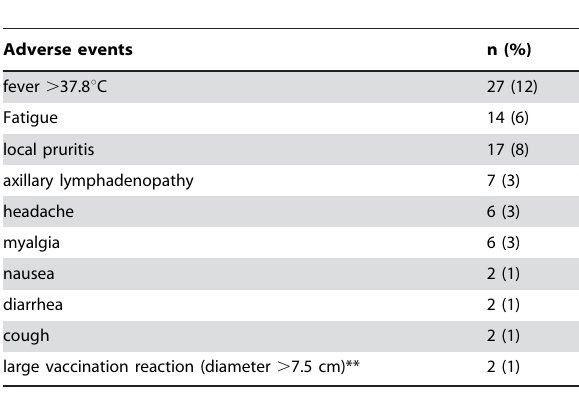
Table 3. Local and systemic symptoms among the 226 volunteers after the